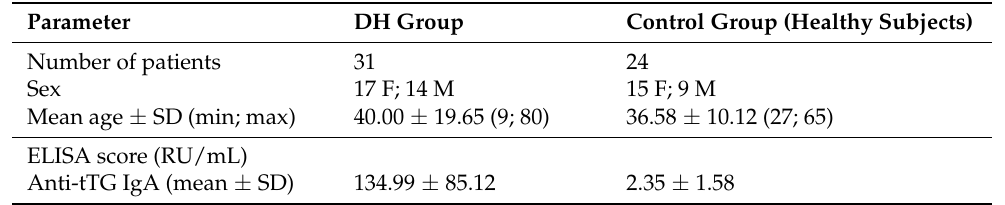
Table 1. Characteristics of the examined